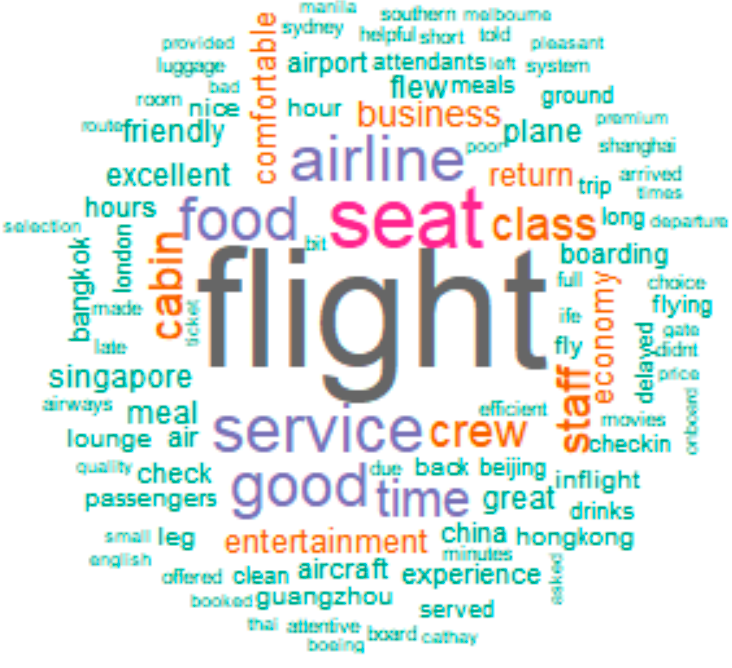
Figure 3. The result of the word cloud.